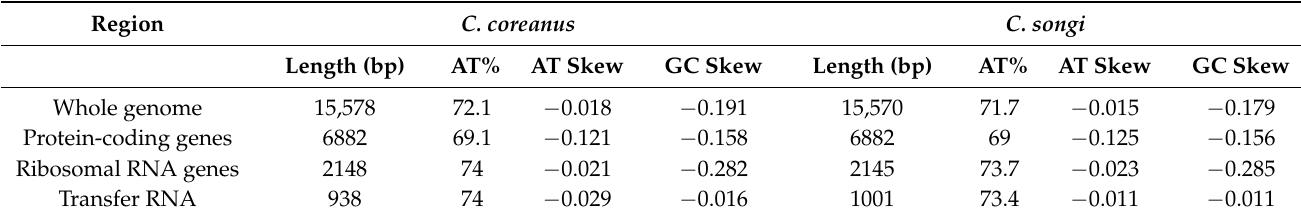
Table 4. Base composition, the percent of A and T, AT skew and GC skew of C. coreanus and C. songi . Region C. coreanus